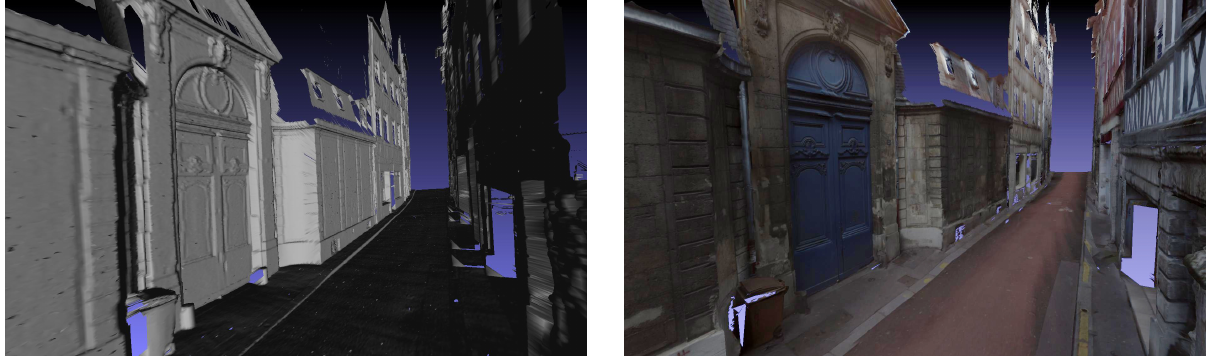
Figure 7. Texturing result on a region in Rouen, France